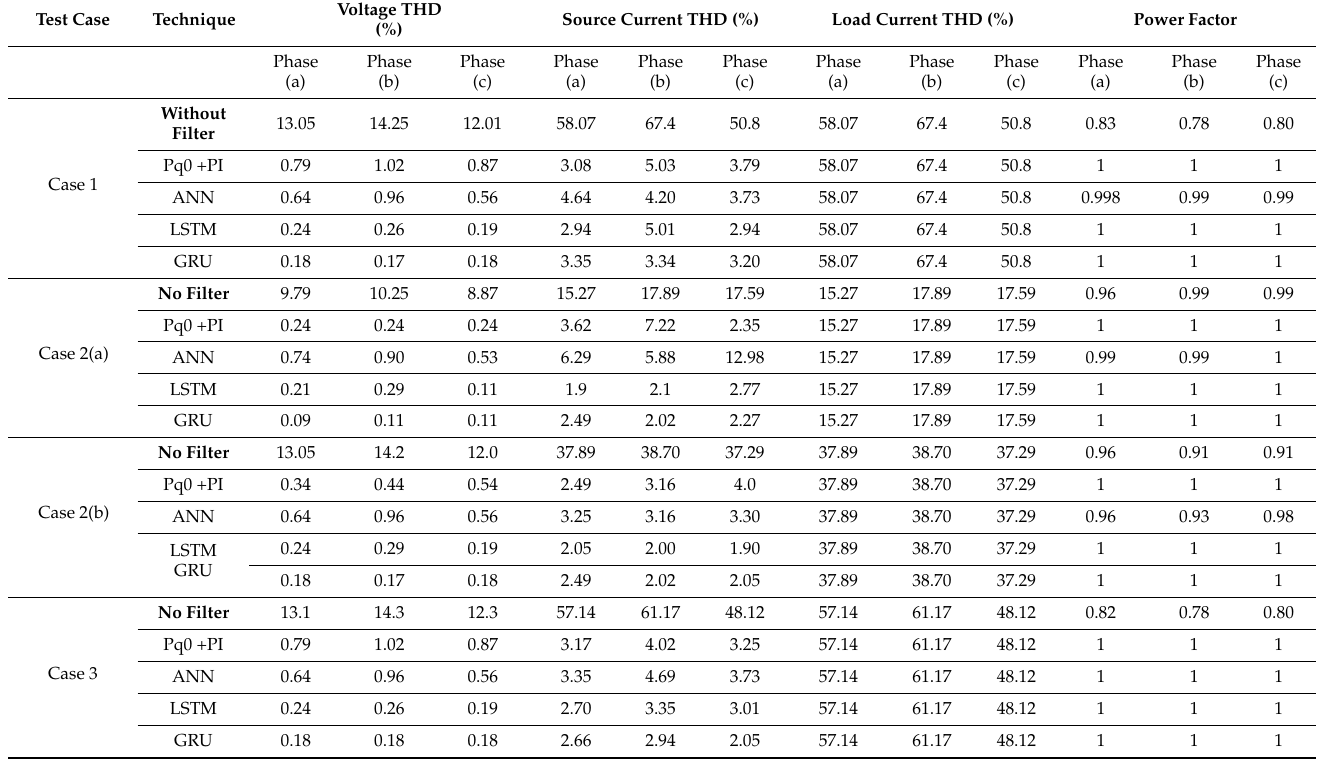
Table 5. Comparative analysis of the total harmonic distortion